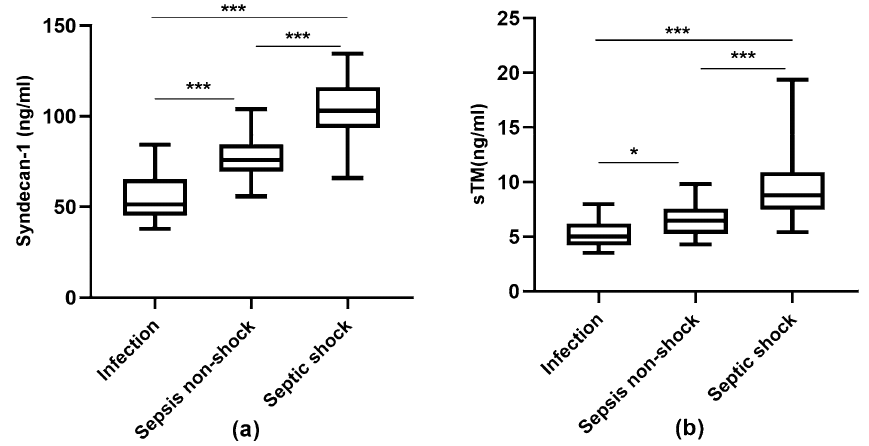
Figure 2. Comparison of serum syndecan-1 levels ( a ) and sTM ( b ) levels among groups . Comparisons among multiple groups were conducted by one-way analysis of variance, and those between two groups were carried out with the Least Significant Difference (LSD) post hoc test. P < 0.05 were considered statistically significant. *Denotes P < 0.05, ***Denotes P < 0.001. sTM serum thrombomodulin.